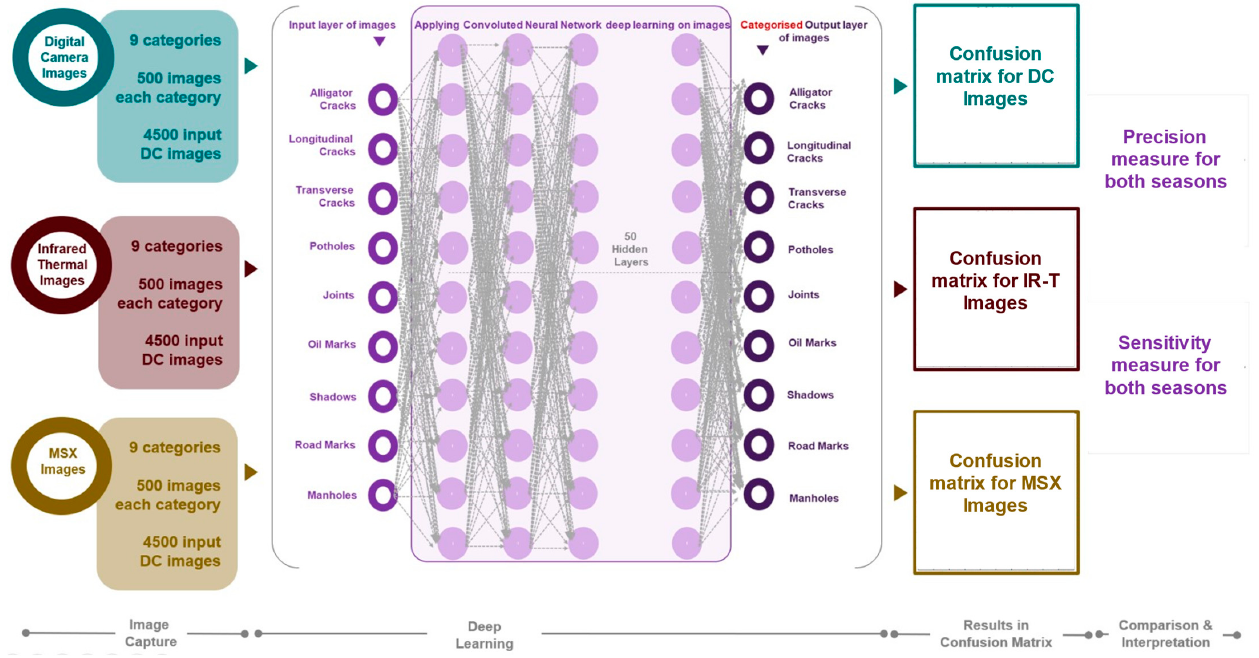
Figure 1. Project workflow.